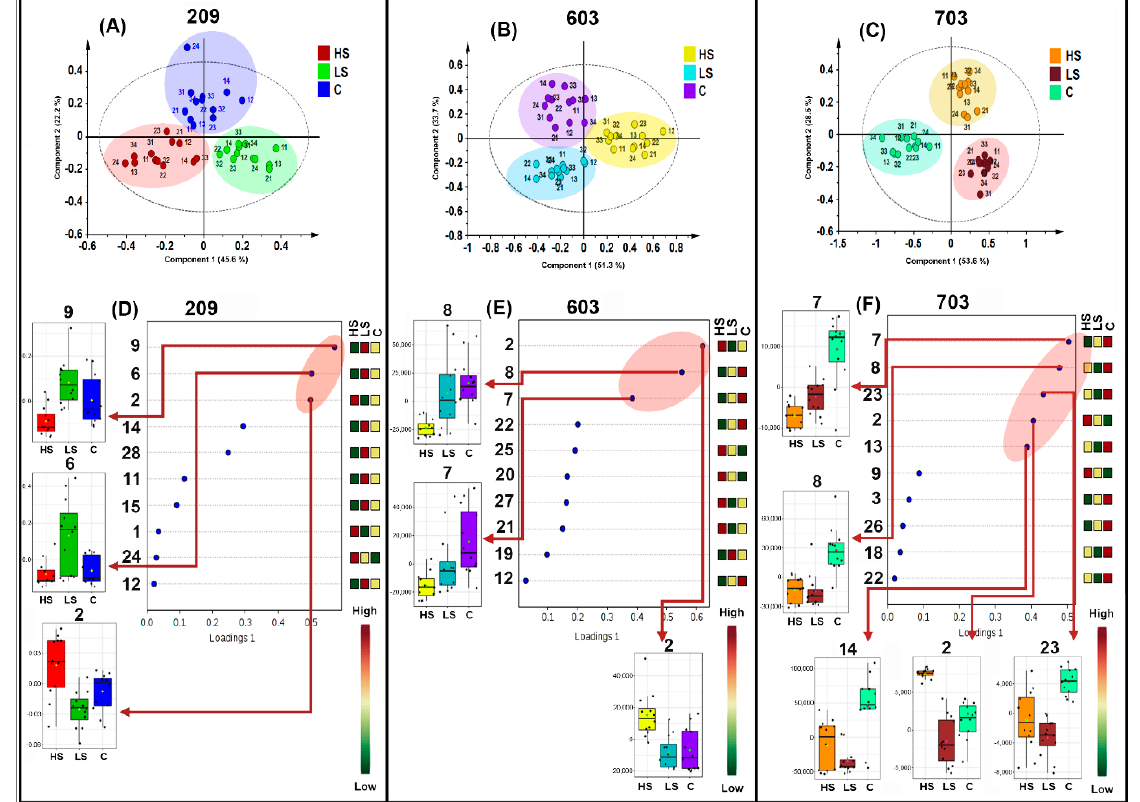
Figure 3. Comparative analysis of the LC-MS data of aerial part-derived extracts from those P. peruviana plants collected at different growth substages (209, 603, and 703) under different salt treatments (HS: high salinity (90 mM NaCl); LS: low salinity (30 mM NaCl); C: Control (without NaCl treatment)) by means of sparse partial least squares discriminant analysis (sPLS-DA) to establish the metabolic differences (R 2 > 0.85; Q 2 > 0.78). Scores plot supervised by salt treatment: HS: red; LS: green; C: blue for the dataset from plants at the substages ( A ) 209, ( B ) 603, and ( C ) 703. Loadings plot ranking the most-influencing metabolites to discriminate treatments for the dataset from plants at the substages ( D ) 209, ( E ) 603, and ( F ) 703. Metabolites are numbered according to the annotated metabolite list presented in Table A2. The highly top-ranked metabolites per growth substage are highlighted in red ellipses.